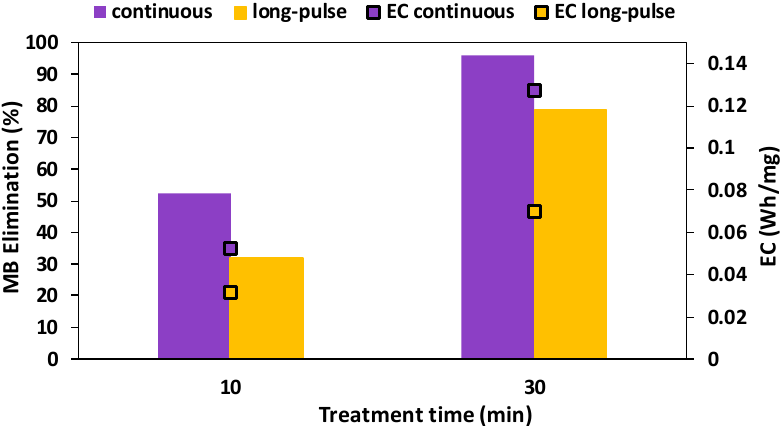
Figure 3. MB elimination (20 mg/L) at a catalyst concentration of 800 mg/L. Continuous radiation (purple), and long-pulse radiation (yellowish).